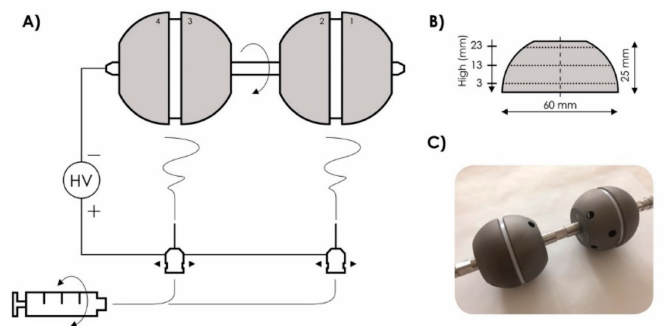
Figure 1. Diagram of the experimental deposition method ( A ). Dimensions of model acetabular cups and levels, at which the thickness of the deposited layer was measured ( B ). An image of four implants attached to the shaft of the rotary collector (rotary